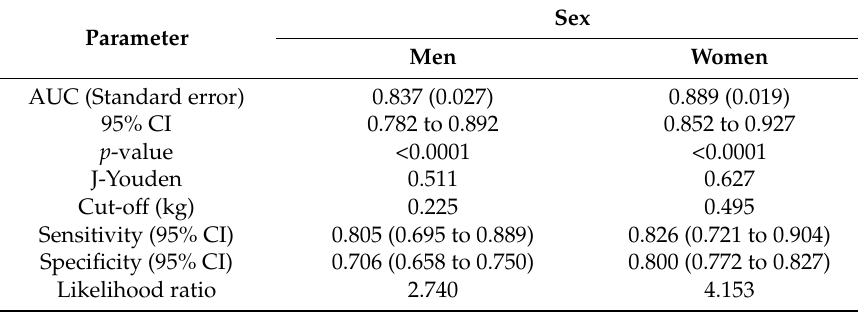
Table 2. Diagnostic properties of ratio of fat mass to muscle mass to detect high risk of MetS according to the International Diabetes Federation (IDF) by